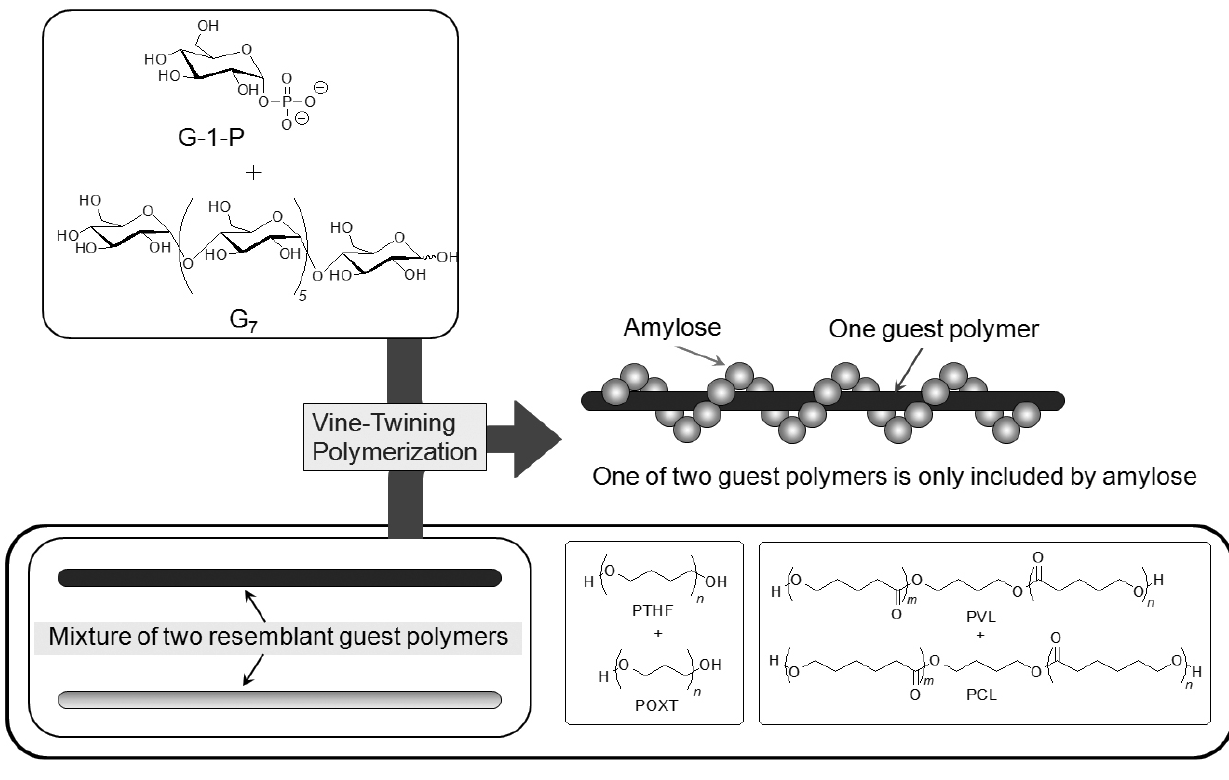
Figure 10. Amylose selectively includes one of two resemblant polyethers or